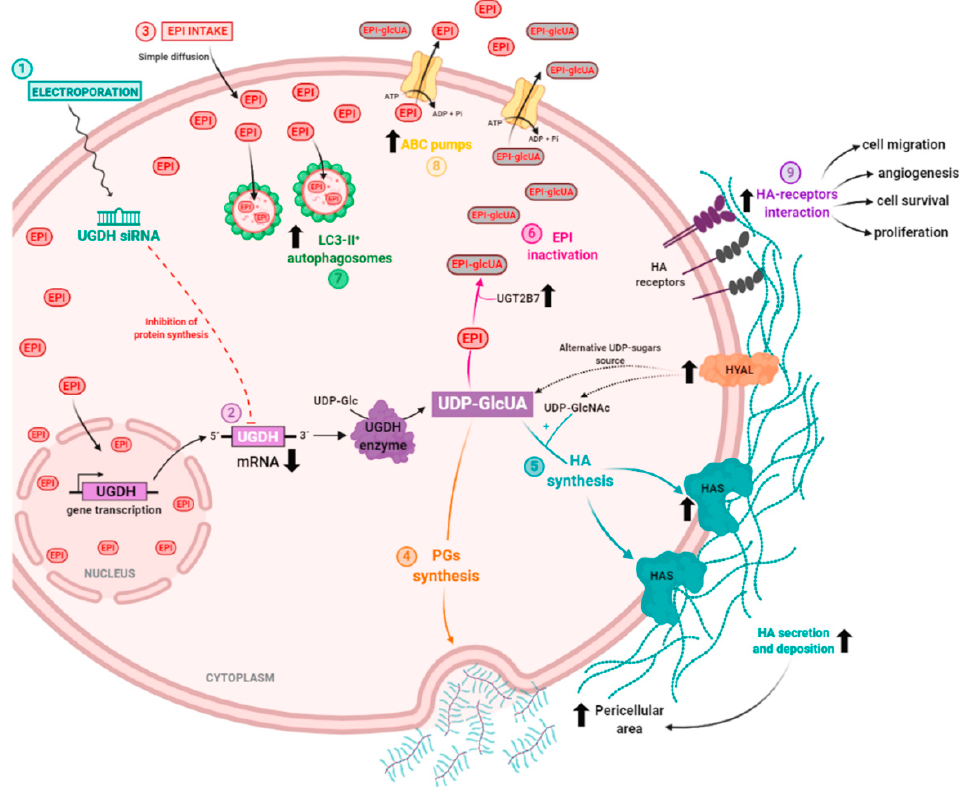
Figure 9. Proposed mechanism of epirubicin resistance in breast cancer cells during UGDH knock ‐ down.